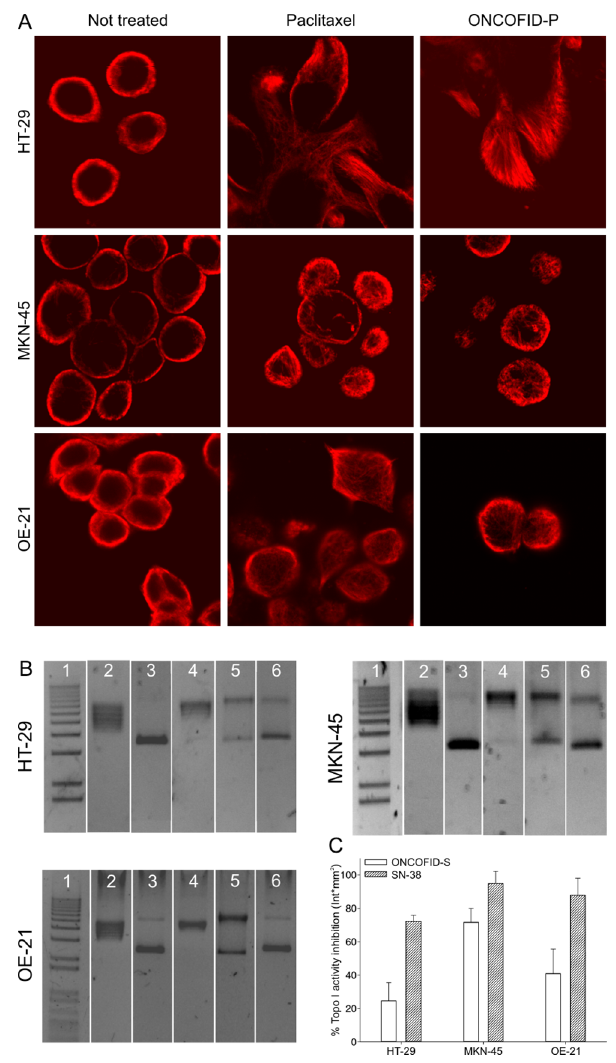
Figure 4. Assessment of bioconjugate mechanism of action. A, rearrangement of tumor cell microtubular architecture after drug treatment. HT-29, MKN-45 and OE-21 cells were treated with ONCOFID- P or free paclitaxel for 4 hours at 37 u C. After treatment, cells were fixed, permeabilized, and stained with an anti- b -tubulin mAb and anti-mouse Ig Alexa 546-conjugated antiserum. Cells treated with free drug or bioconjugate disclosed the same interferences on the microtubular mesh. B, inhibition of Topo I activity after ONCOFID-S or SN-38 treatment in HT-29, MKN-45 and OE-21 cells. Gels show the supercoiled or relaxed forms of pBR322 plasmid after incubation with a 1:50 dilution of nuclear protein neat extracts obtained from tumor cells treated with conjugated or free drug for 4 hours. Lane 1, marker; lane 2, relaxed pBR322 plasmid (positive control); lane 3, supercoiled plasmid (negative control); lane 4, supercoiled plasmid in the presence of nuclear protein neat extract from drug-untreated cells; lane 5, supercoiled pBR322 admixed with nuclear protein neat extract from ONCOFID-S treated cells; lane 6, supercoiled pBR322 admixed with nuclear protein neat extract from SN-38-treated cells. C, quantification of the reactions shown in B. Figure reports mean 6 SD of 3 independent experiments.